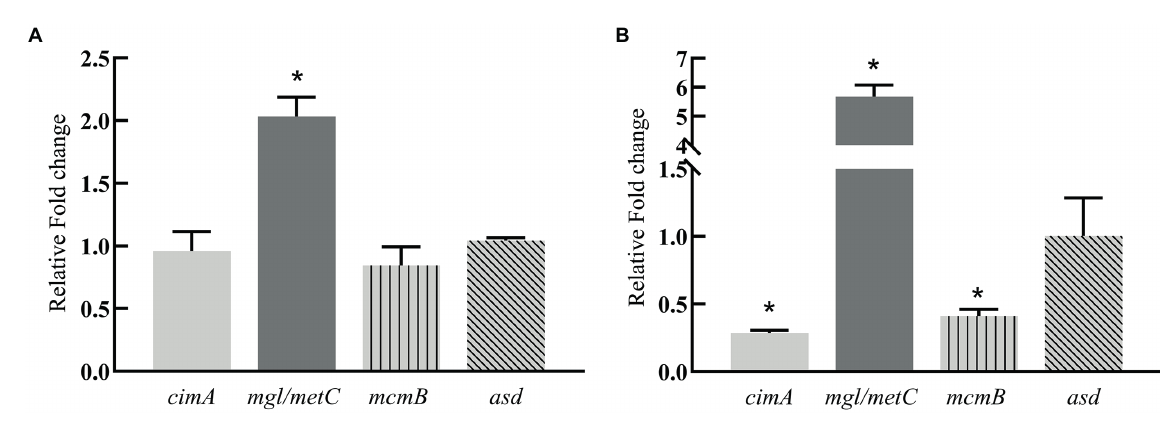
FIGURE 5 Relative expression levels of key genes ( cimA ; mgl / metC ; mcmB ; asd ) in four pathways related to 3 HV synthesis in strain ATCC 33500 exposed to short-term (A) and long-term (B) silkworm excrement. All the data are presented as means of duplicates with their standard errors. [*significant differences ( p <